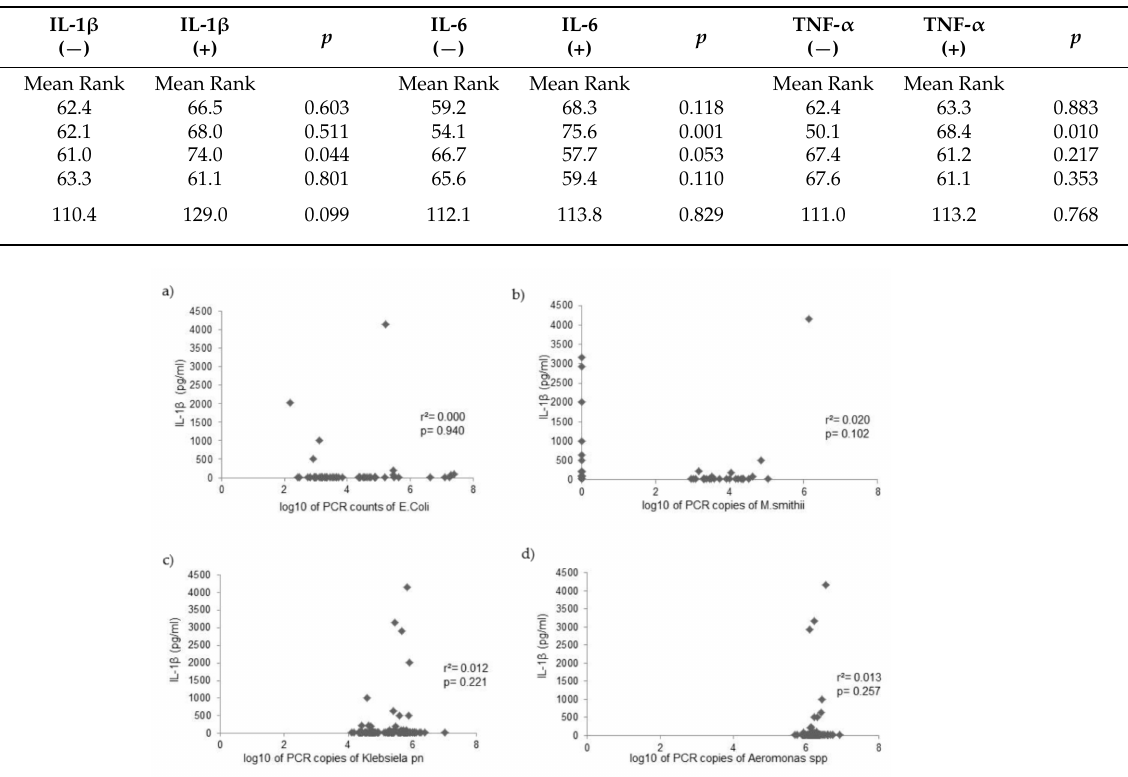
Figure 2. Correlation between IL-1 β levels and PCR copies of ( a ) Escherichia coli , ( b ) Methanobevribacter smithii , ( c ) Klebsiella pneumoniae , and ( d ) Aeromonas spp. in the duodenal